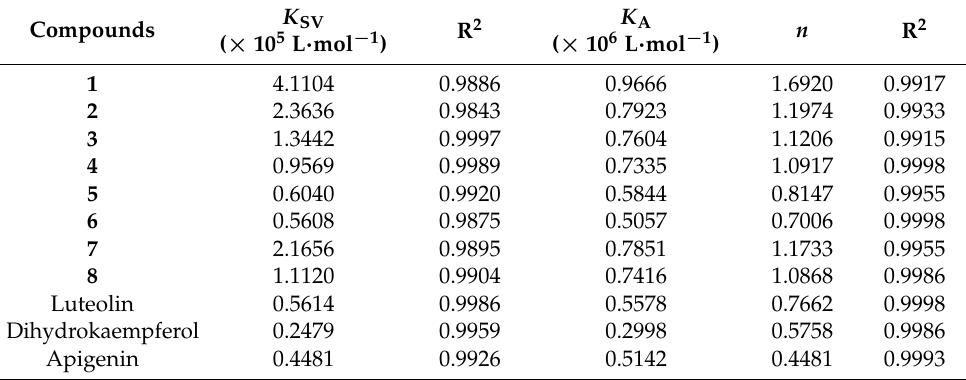
Table 4. Fluorescence quenching effects of the isolated compounds ( 1 – 8 ) and their parent compounds (luteolin, dihydrokaempferol, and apigenin) on the bacterial neuraminidase.